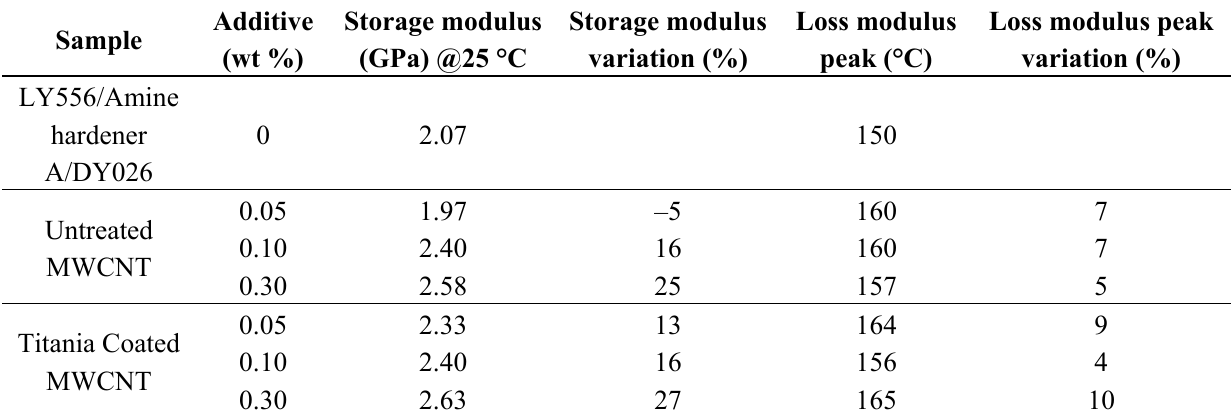
Table 7. Epoxy system 2: Thermo-mechanical properties of nanocomposites.